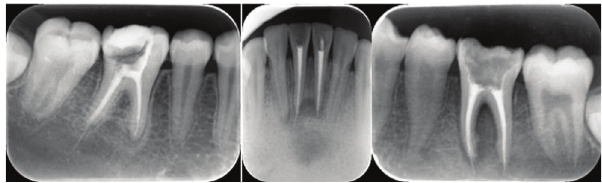
Figure 11: Extrusion of gutta-percha beyond the radiographic apex.